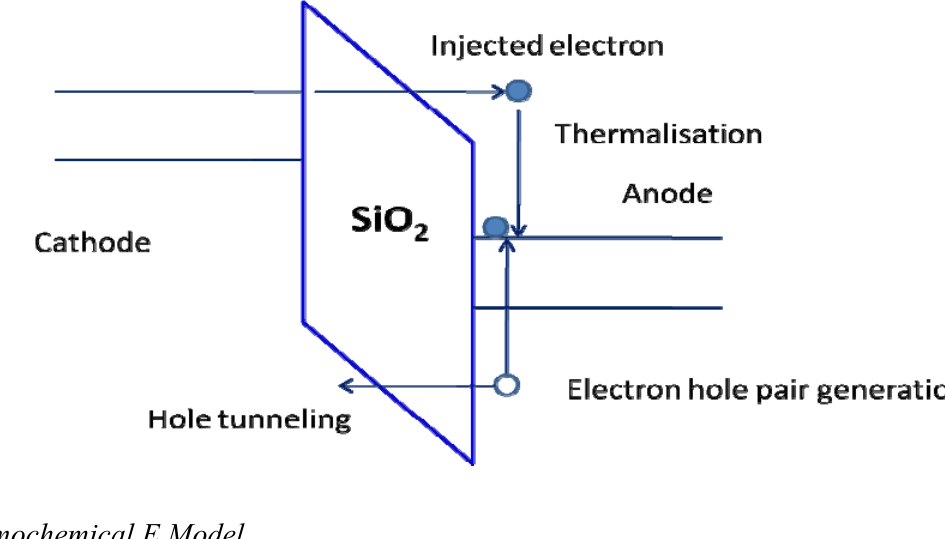
Figure 3. Energy band diagram illustrating the anode hole injection mechanism in 1/E